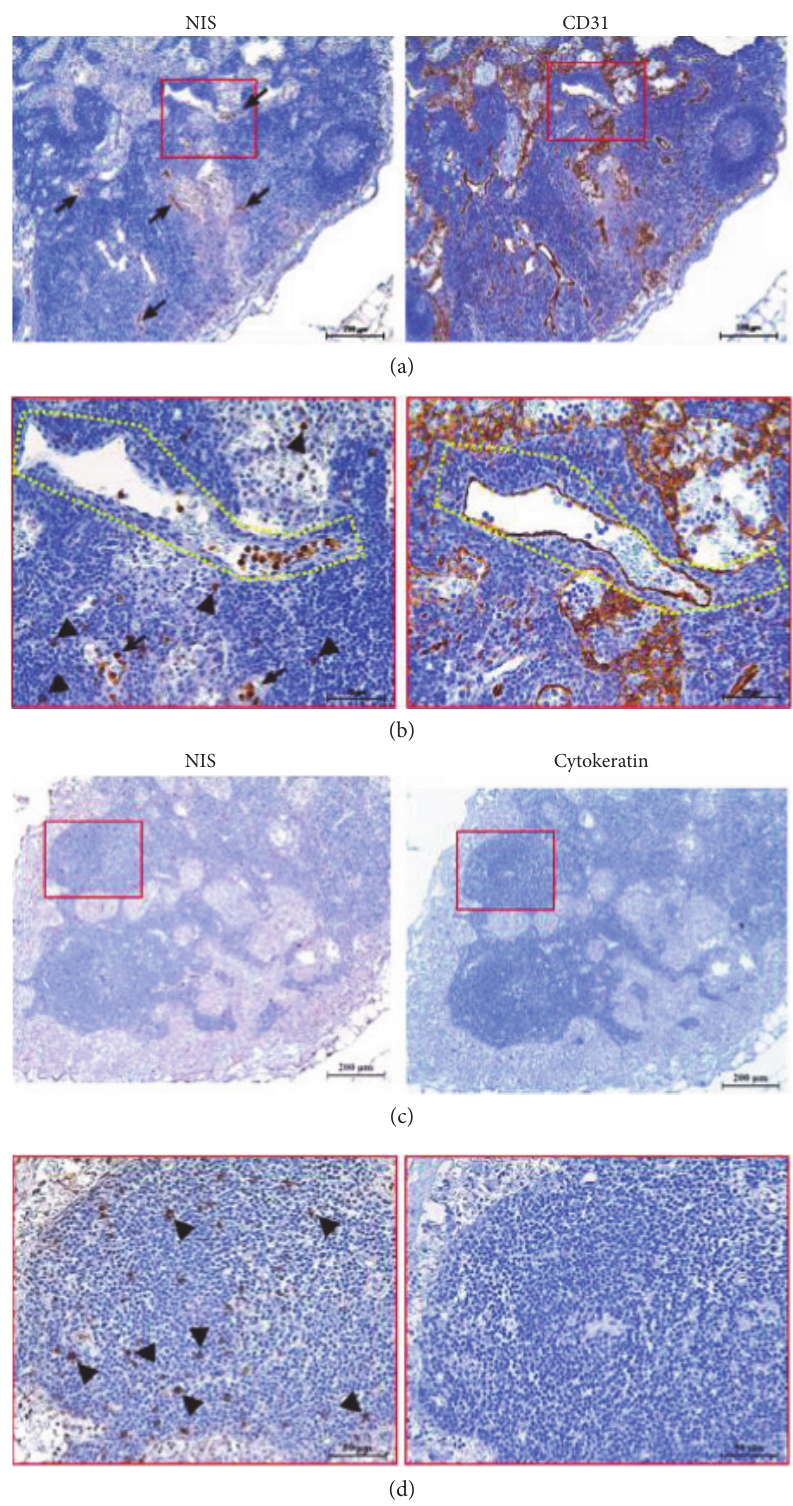
Figure 5: Expression of NIS protein in the Tg-positive thymus specimen. Sodium iodide symporter (NIS) is observed inside the vasculature stained with the CD31 antibody (a and b; arrows) and in thymocytes (b and d; arrowheads). Hassall ’ s corpuscles were stained with cytokeratin. But Hassall ’ s corpuscles were not observed in this thymus specimen. The low (a and c) and high (b and d) magni fi cations of the images are 100x and 400x, respectively. The scale bars represent 200 μ m (a and c) and 50 μ m (b and